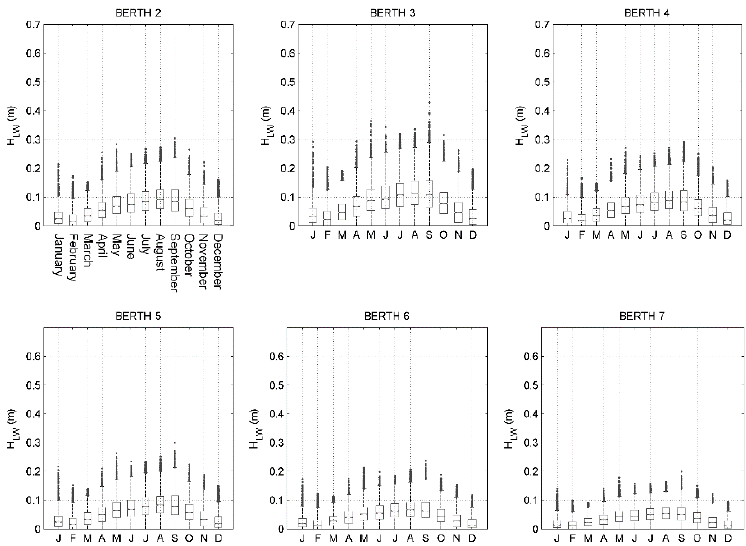
Figure 7. Monthly distributed box ‐ plot for H LW for Berths 2 to 7.